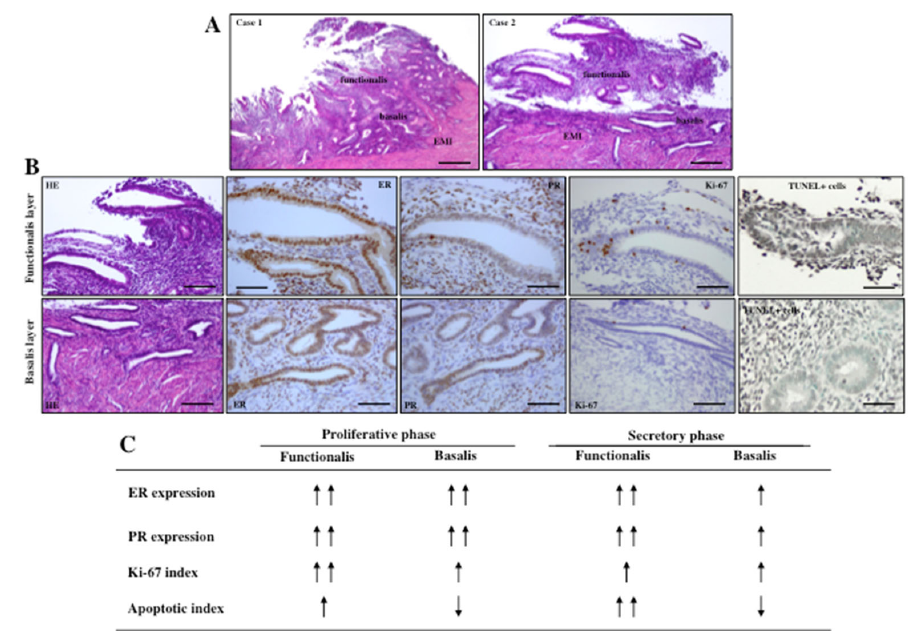
Figure 1. ( A ) Hematoxylin and eosin (HE) ‐ stained slides showing degradation of functionalis endometria and intact basalis endometria derived from the hysterectomy specimens of two different cases with adenomyosis during menstruation. ( B ) Immunohistochemical staining of estrogen receptor (ER), progesterone receptor (PR), Ki ‐ 67 (cell proliferation marker), and TdT ‐ mediated dUTP ‐ biotin nick end ‐ labeling (TUNEL) ‐ positive cells in the functionalis endometria (upper row) and basalis endometria (lower row) derived from the same patient with adenomyosis during menstruation. ( C ) Shows the immunohistochemical expression patterns of ER, PR, Ki ‐ 67 index, and apoptotic index in the functionalis and basalis endometria during the proliferative phase and secretory phase of the menstrual cycle. These slides were reproduced with permission from the article of Khan et al. [17]. Scale bar = 50 μ m or 100 μ m.